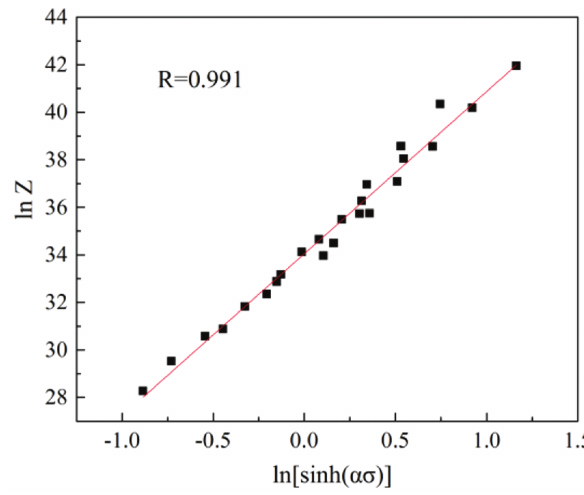
Figure 7: Relationship between ln Z and ln sinh ασ ð Þ½ (cid:2) .